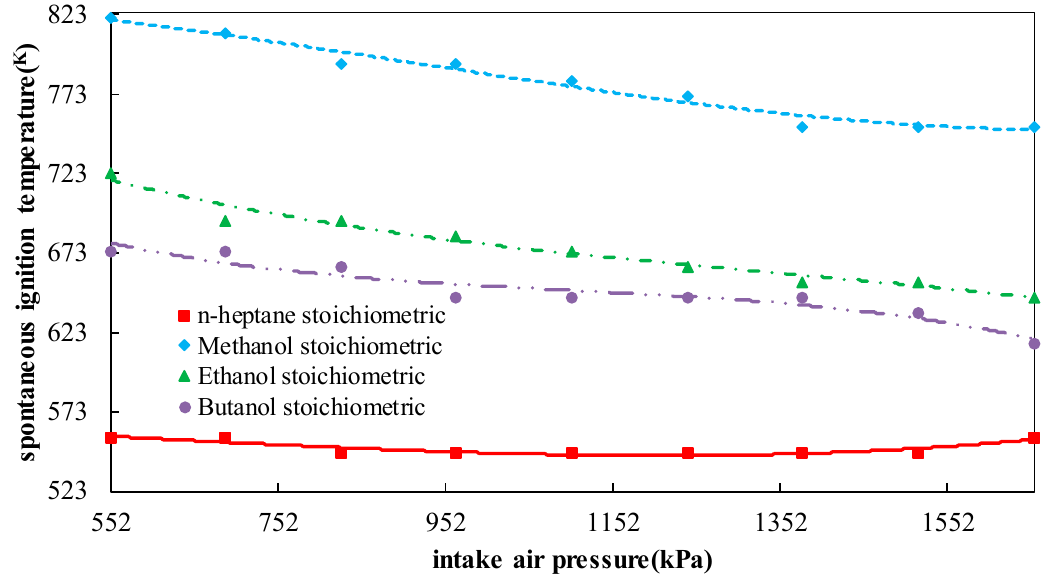
Figure 3. The relationship between intake air pressure and spontaneous ignition temperature at 473 K, stoichiometric ratio .